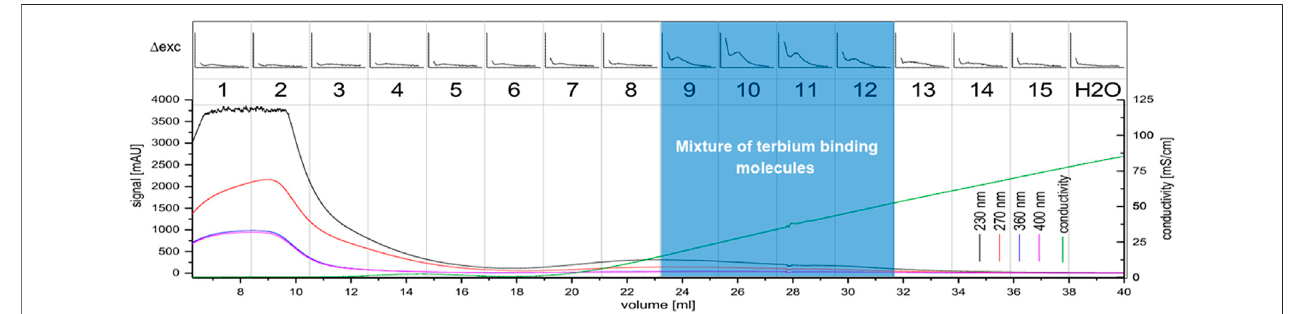
FIGURE 4 | Anion exchange chromatography of the C. brevissima biomass extract; The UV-signal in mAU is plotted against the elution volume from the wavelengths 230 nm (black), 270 nm (red), 360 nm (blue) and 400 nm (pink). The conductivity is displayed in green. 2.5 ml fractions were collected (numbered 1-15). EachfractionwastestedforinteractionwithTb via luminescencespectrometry.The Δ RFU-values(beforeandafteradditionofTb)measuredat545 nm(200 – 5000,ifnot noted otherwise) are plotted against the excitation wavelength (230 – 402 nm). Also, the H 2 O-background measurement is displayed. Fractions 9-12 were pooled.